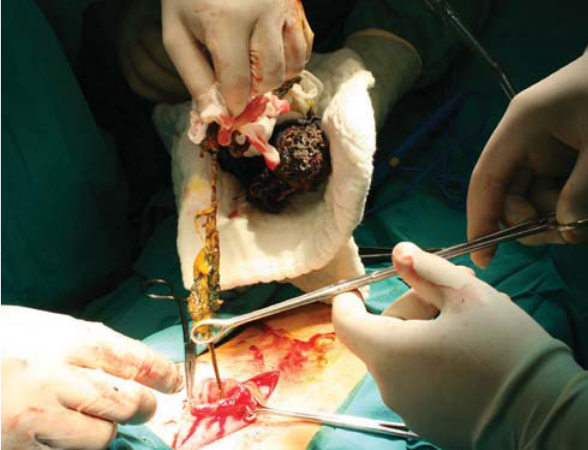
Figure 2 - The tail of the bezoar pulled back from the intestine